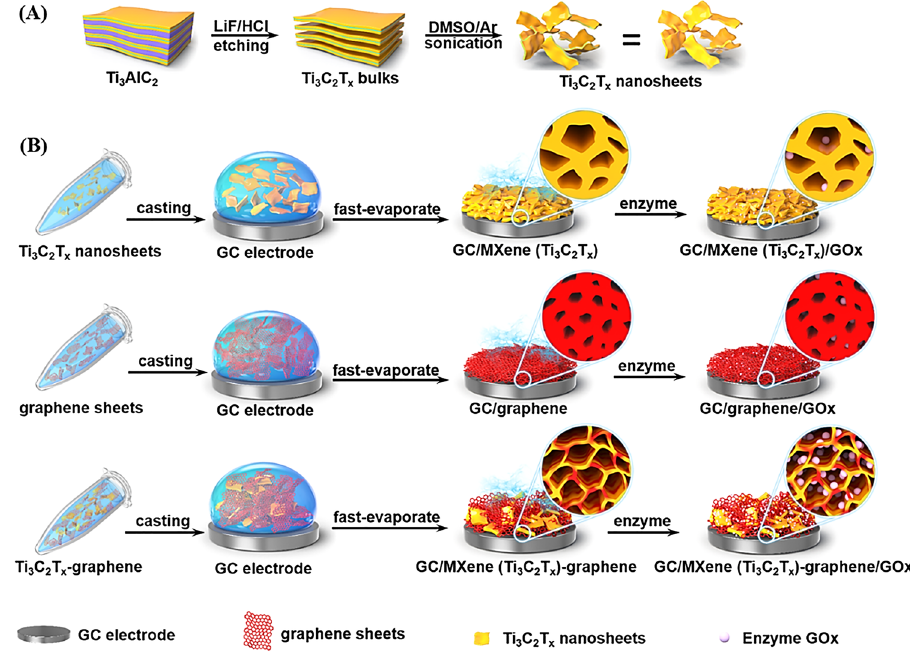
Fig. 4 A The preparative processes of MXene nanosheets and B MXene-graphene hybrid films for the immobilization of enzymes with glucose biosensing application. LiF—Lithium fluoride; DMSO—Dimethyl sulfoxide; GC—Glassy carbon; GOx—Glucose oxidase. Reproduced with permission from Ref. [60]. Copyright 2019 American Chemical